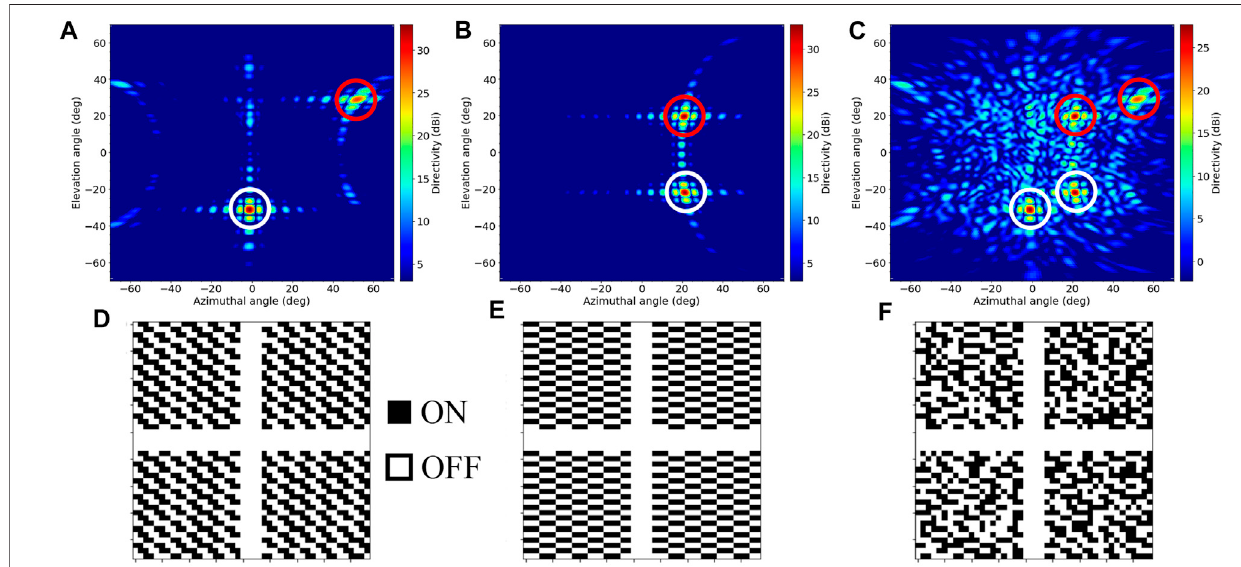
FIGURE 2 | (A – C) Numerically calculated far- fi eld radiation patterns created by the RIS illuminated by a plane wave at − 45 ° azimuth incidence and set in a single- beam (A,B) and adouble-beam (C) con fi gurations. The desired beams areencircled withthewhitecolorand theparasitic ones withthered color. (D – F) Corresponding binary con fi gurations. The white cross represents the separation of 2 cm between the four metasurfaces constituting the RIS.